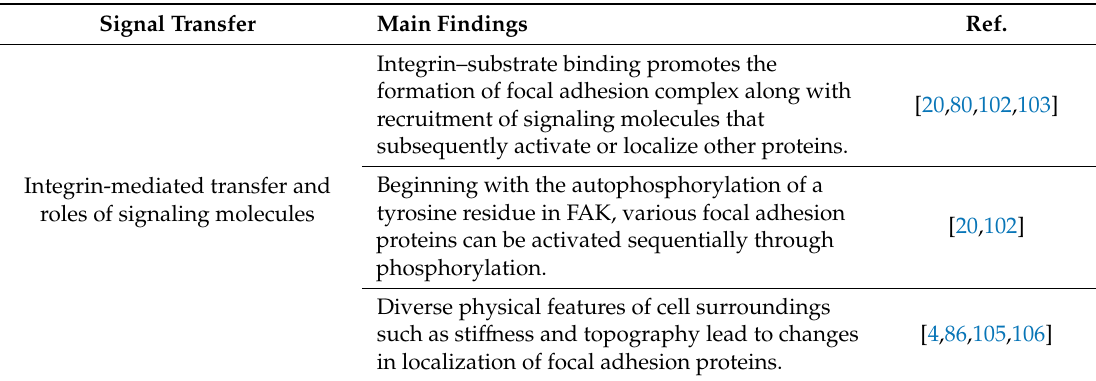
Table 7. Cytoplasmic transfer of the material-sensing